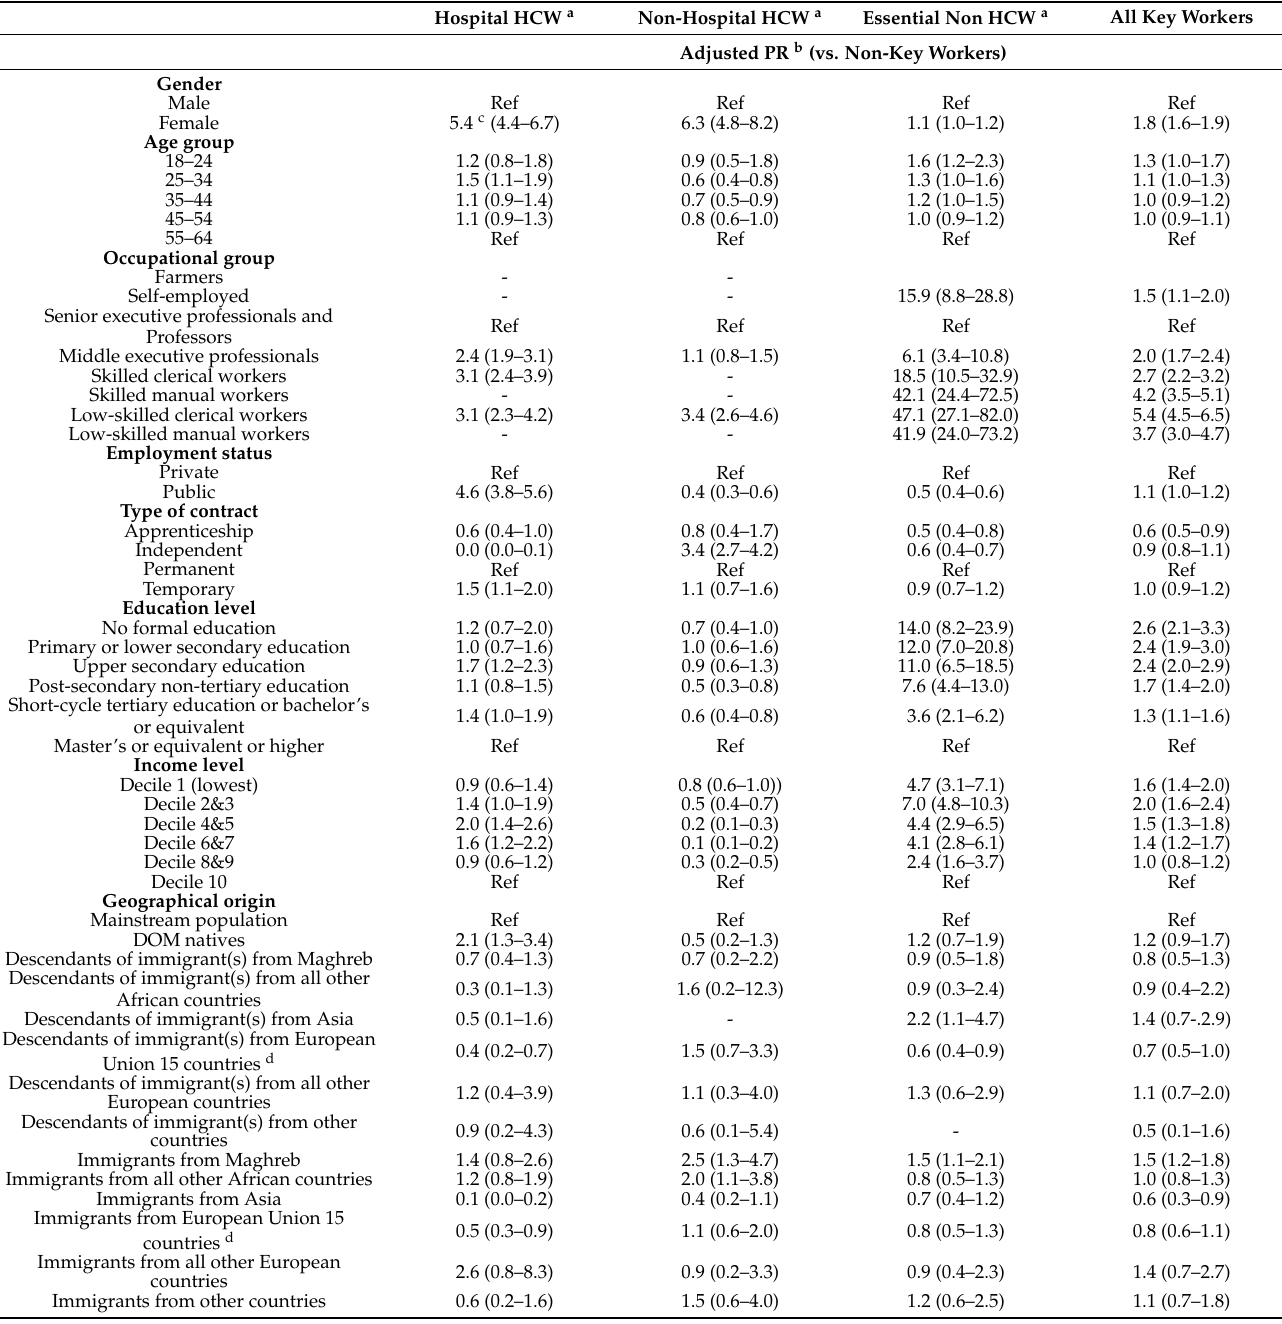
Table 2. Estimated adjusted prevalence ratios (PR) for the association between socio-demographic characteristics and working as a key worker in each sub-group of key workers, compared to non-key workers (stratified multivariate